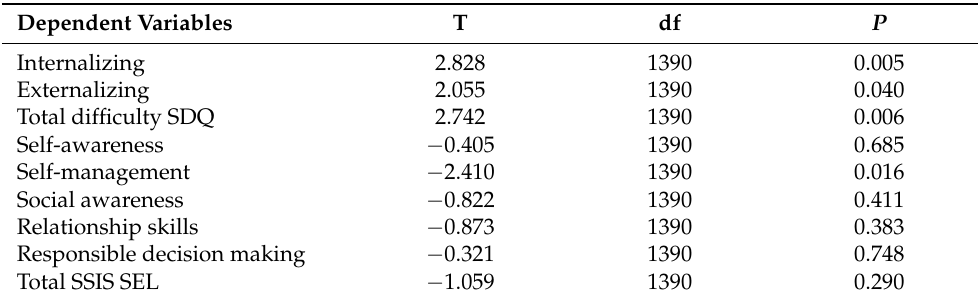
Table 3. Independent samples t -test comparing pre-intervention scores for study variables between experimental and control